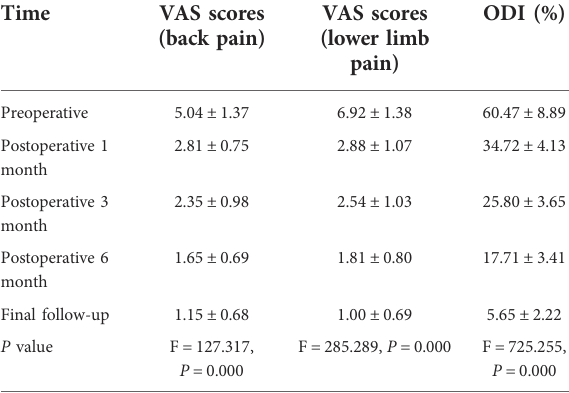
TABLE 1 Clinical outcomes in different